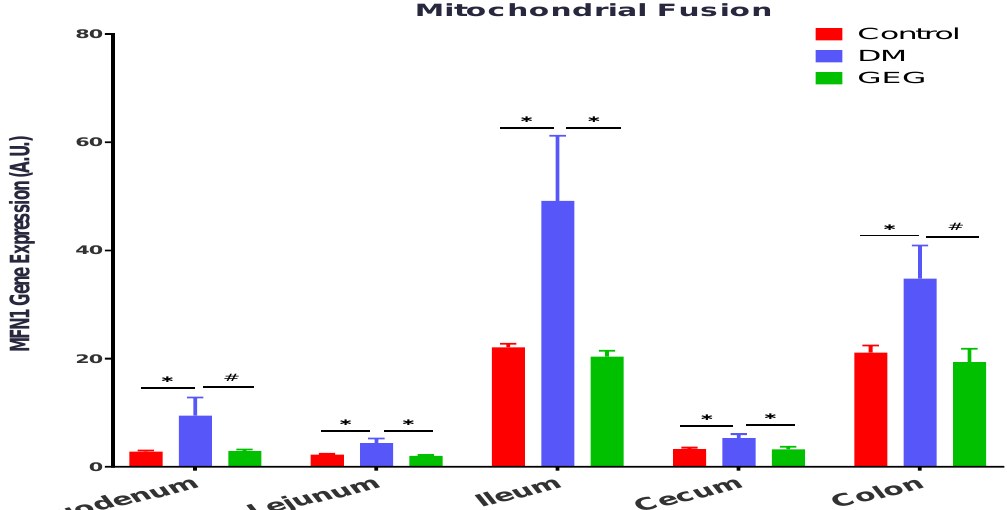
Figure 6. Effect of gingerol-enriched ginger (GEG) on mRNA gene expression of MFN1 3 in duode- num, jejunum, ileum, cecum, and colon of rats. Data is expressed as mean ± SEM. n = 6 – 8 per group. Data was analyzed by one-way ANOVA followed by a post hoc Tukey’s test. * p < 0.05. # 0.05 < p < 0.1. In terms of the FIS1 gene, the FIS1 gene expression levels were elevated in the jejunum, ileum, cecum, and colon of HFD+STZ-treated animals (DM group), as compared to the control group (Figure 7). The GEG group tended to suppress FIS1 gene expression in the ileum (Figure 7, 0.05 < p < 0.1).